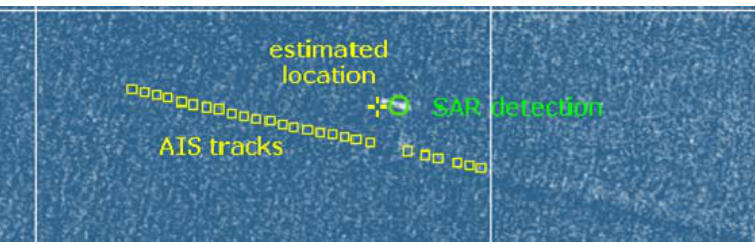
Figure 7. Illustrative description of the SAR-AIS route tracking algorithm.